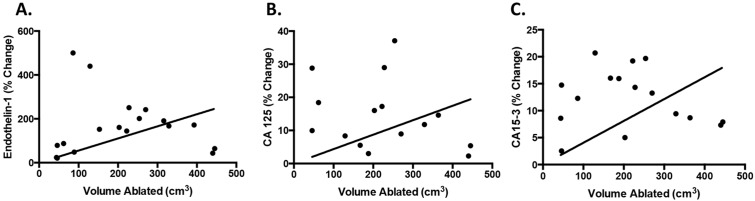
Correlation of biomarker-release to volume of uterine fibroid ablated in patients.The percent change of biomarker in pre- and post-treatment plasma samples was compared to the volume of the fibroid that was ablated and showed a correlation for endothelin-1 p = 0.0026, R2 = 0.541 (A), CA125 p = 0.0073, R2 = 0.129 (B) and CA15-3 p = 0.0004, R2 = 0.3 (C).